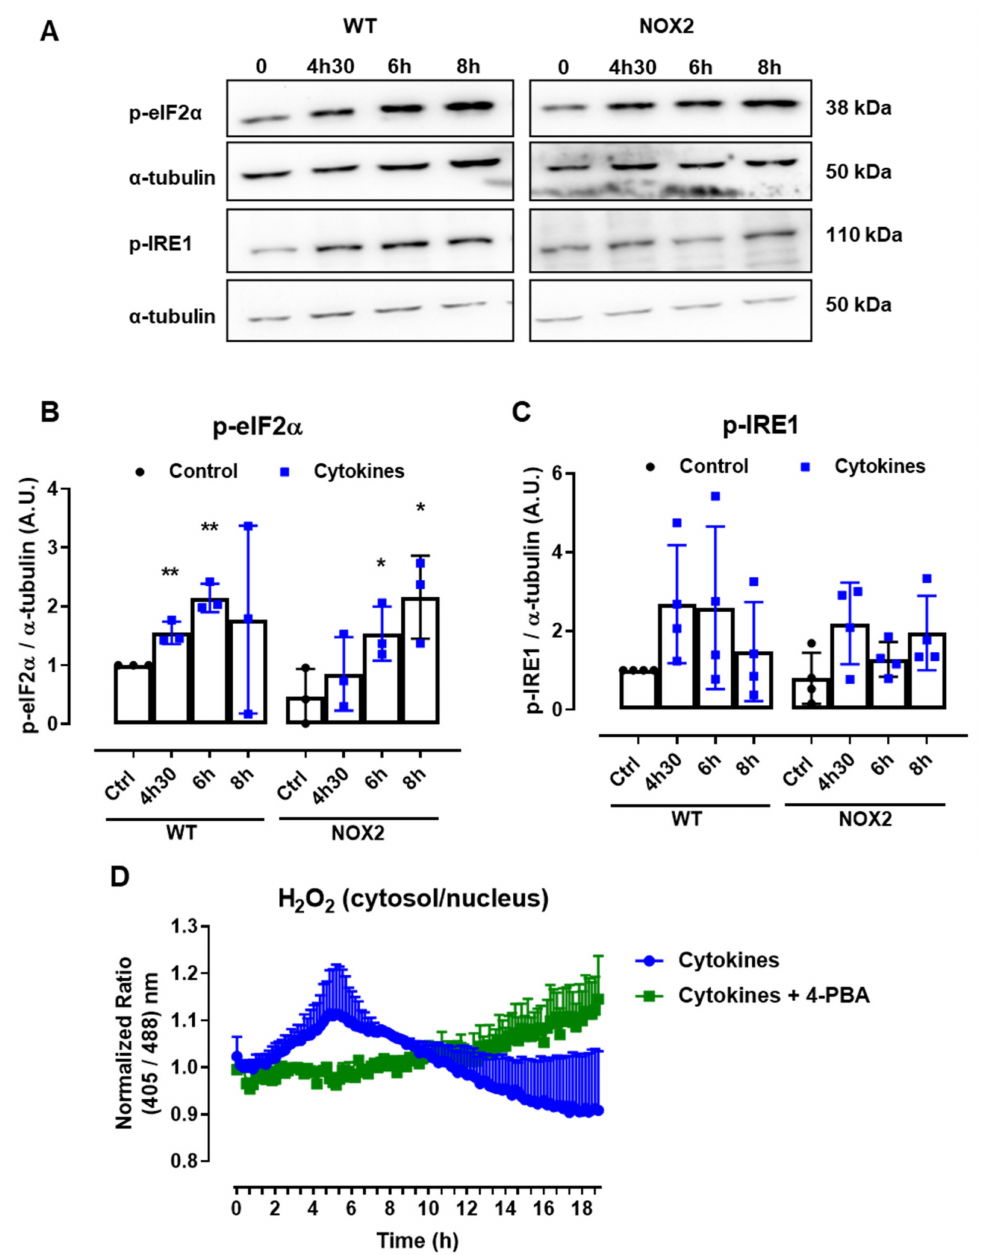
Figure 6. The protein expression of ER stress markers in the islets from C57BL/6J (WT) and NOX2 KO (NOX2) mice exposed to proinflammatory cytokines. The islets were incubated in the absence (Ctrl) or presence of a proinflammatory cytokine mix (10-U/mL IL-1 β + 100-U/mL TNF + 14-U/mL IFN- γ ) for the indicated periods. A Western blot analysis was performed for p-eIF2 α and p-IRE1 using α -tubulin as the internal control. ( A ) Representative bands and the respective α -tubulin. ( B , C ) A densitometric analysis of the Western blot: p-eIF2 α ( B ) and p-IRE1 ( C ). The results are expressed as the mean ± SD of 3 to 4 independent experiments. * p < 0.05 and ** p < 0.01 versus the respective control of the same genotype. Student’s t -test. ( D ) Dynamic levels of cytosolic/nuclear H 2 O 2 in the islets from roGFP2-Orp1 mice incubated with proinflammatory cytokines in the absence or presence of the ER stress chaperone 4-PBA at 2.5 mM. The fluorescence intensity was captured every 10 min for 18 h. The results are presented as the normalized ratio (405/488 nm) and mean ± SD of 3 independent